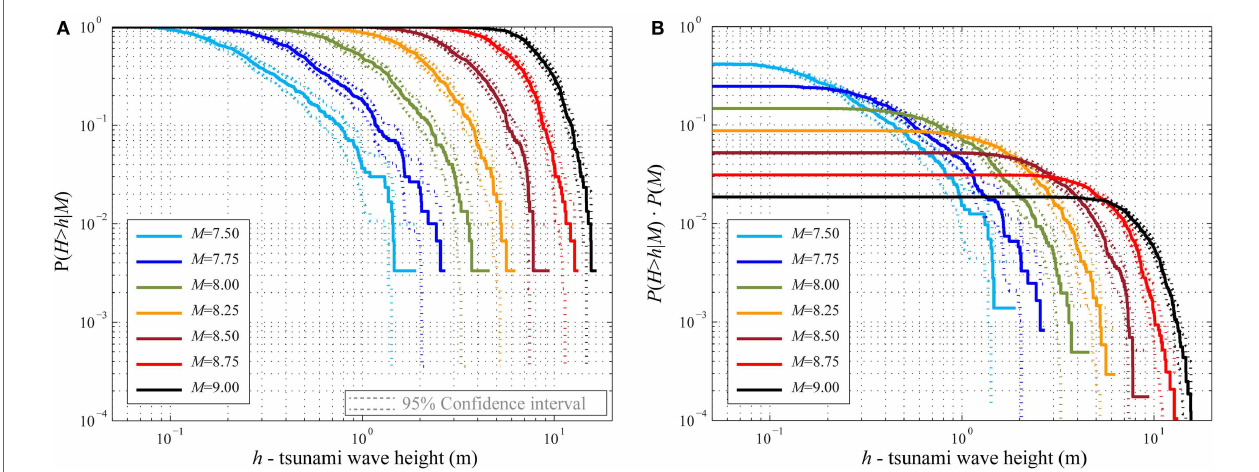
FIGURE 11 | (A) Conditional hazard curve for tsunami wave height. (B) Weighted conditional hazard curves for tsunami wave height.